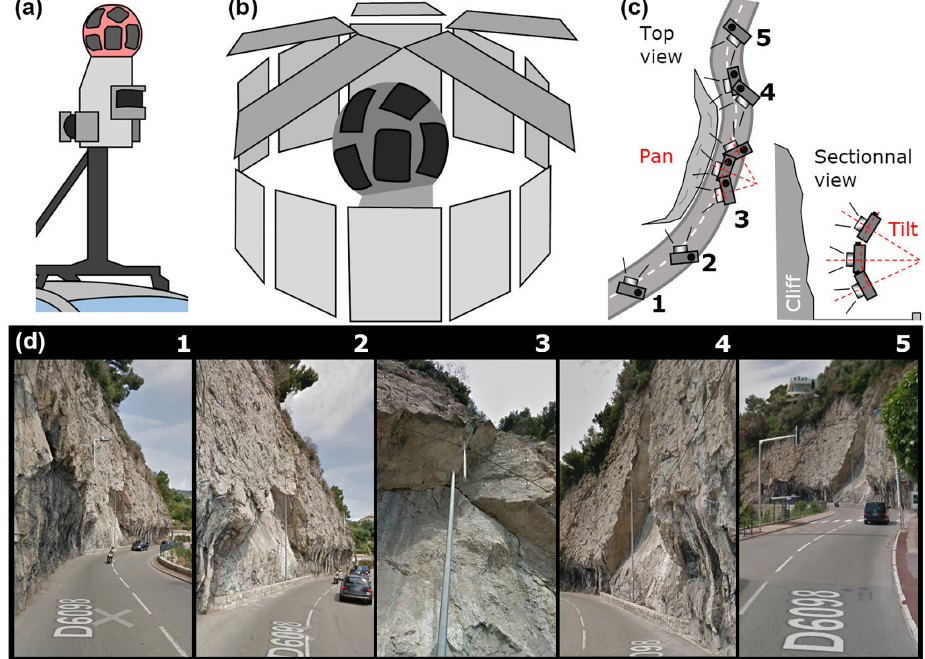
Figure 1. Google Street View (GSV) imagery functioning. (a) Schema of the GSV spherical camera system mounted on a car roof. Sen- sors in black are lidar, on to which the GSV images are draped (based on Google Street View, 2017; http://www.google.com/maps/about/ behind-the-scenes/streetview). (b) Functioning of the GSV spherical panorama built with 15 images. (c) Strategy of the GSV service for SfM- MVS photogrammetry. Numbers correspond schematically to the images in panel (d) . (d) Screen captures of GSV photos from study site 1. The image numbers correspond to those in panel (c) . Note the gap on the street lamp in image 3 due to the panorama construction from the GSV